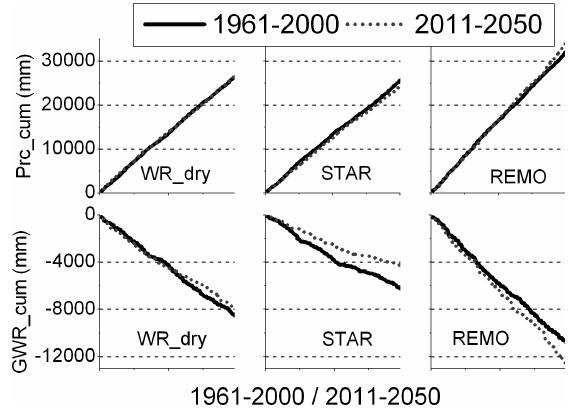
Fig. 7. Comparison of cumulative rates of daily precipitation (=Prc cum) and simulated groundwater recharge (=GWR cum) for the control period 1961–2000 and the defined climate change pe- riod 2011–2050 at the selected hydrotope with arable land/sandy soil, simulated using the climate change scenarios WettReg dry (=WR dry), STAR and REMO.